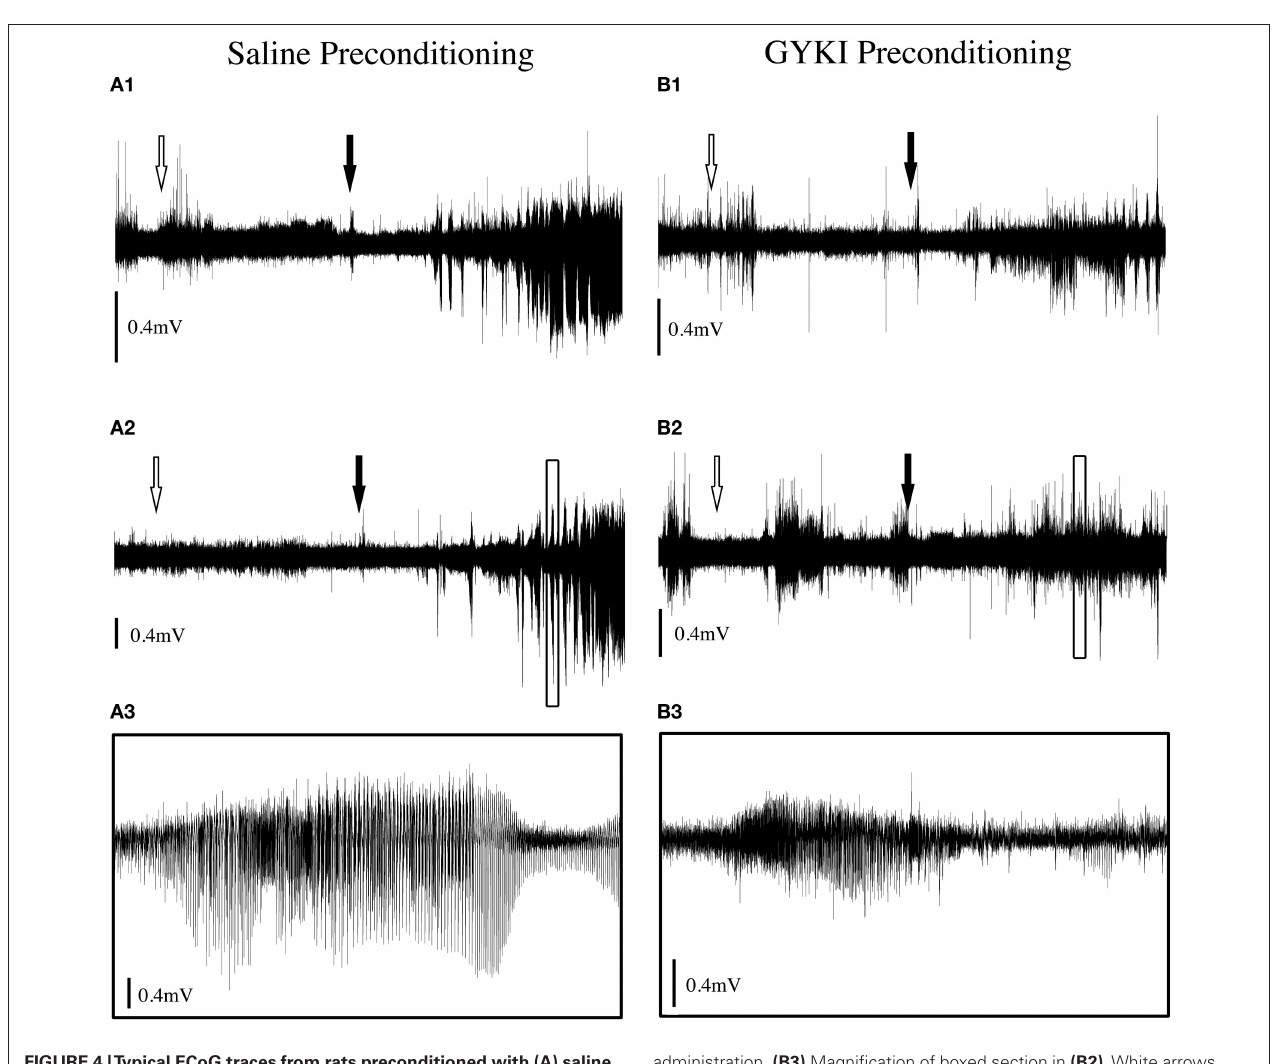
FIGurE 4 | Typical ECoG traces from rats preconditioned with (A) saline or (B) GYKI 52466 (3 mg/kg 90 min) followed by KA (10 mg/kg) seizure challenge. (A1, A2) : Example traces from two saline preconditioned rats. (A3) Magnification of boxed section in (A2) . (B1, B2) Example traces from two rats preconditioned with GYKI (3 mg/kg), 90 min prior to KA